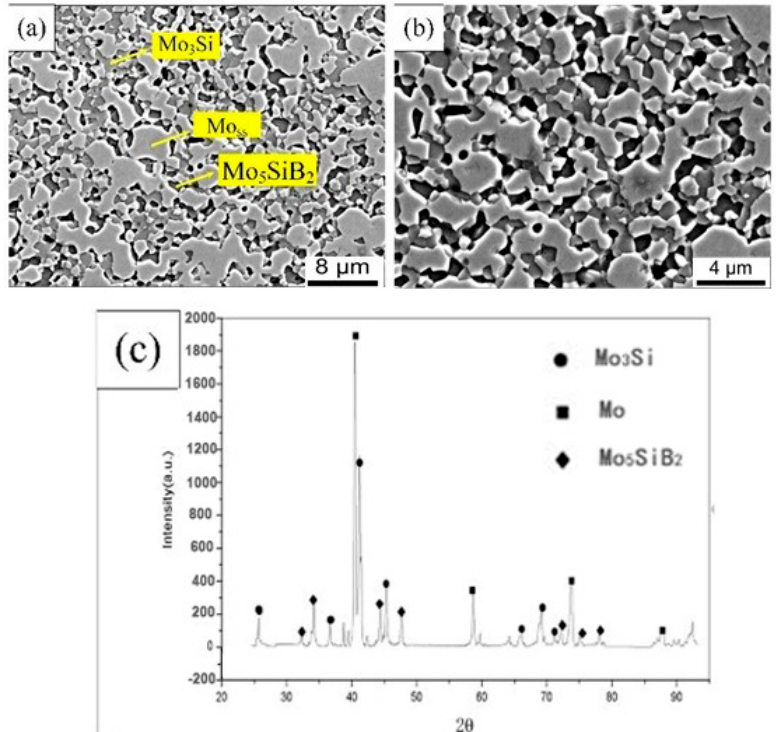
Figure 2. Microstructure of alloy prepared by plasma concussion sintering: ( a ) 3000×; ( b ) 5000×; ( c ) X ‐ ray diffraction pattern.